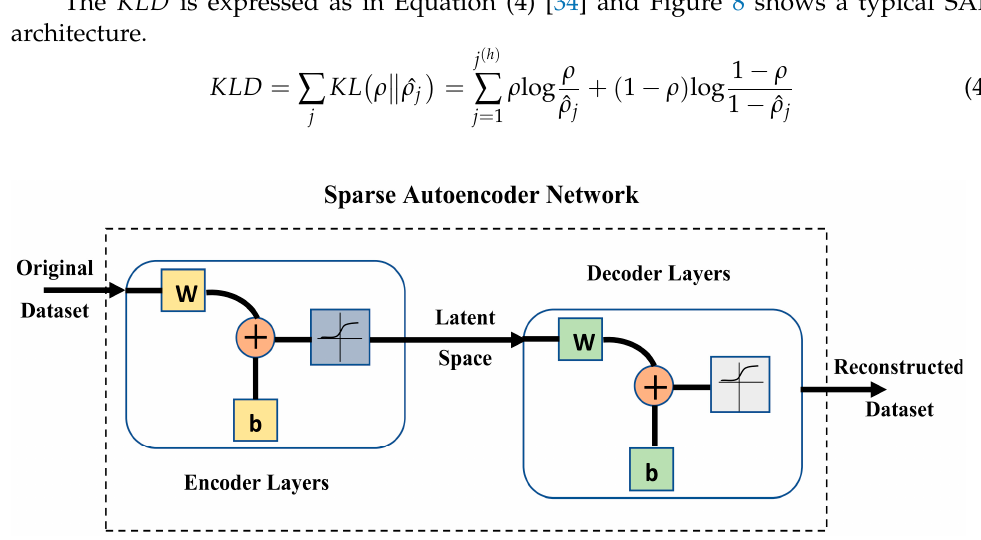
Figure 8. Sparse autoencoder architecture. W and b represent the weight and bias of the neurons in the neural network layers, respectively.